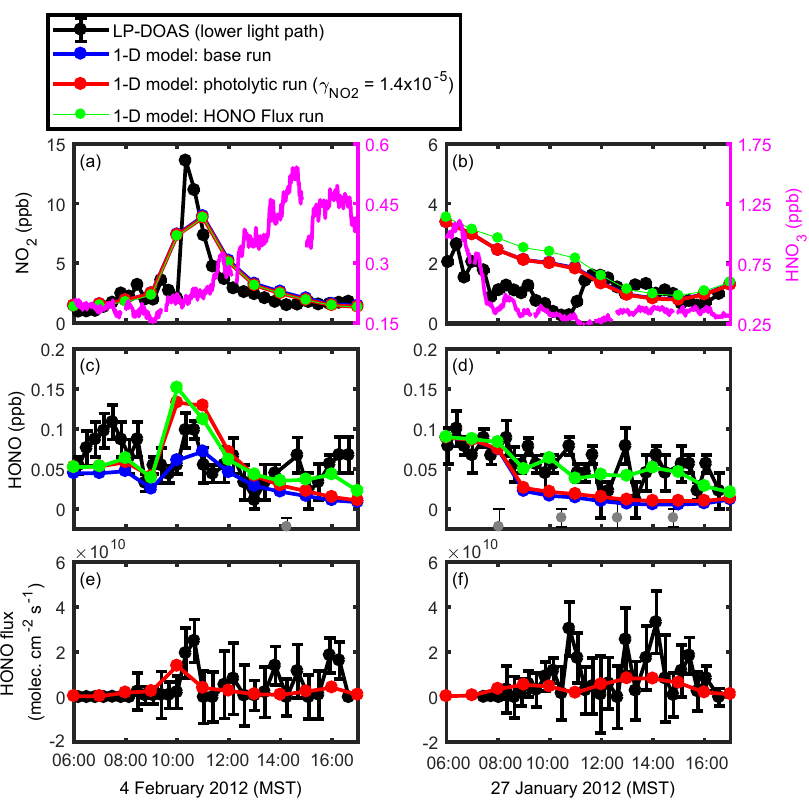
Figure 9. Comparison of modeled and measured NO 2 (a, b) , HONO (c, d) , and HONO flux at 19ma.g.l. (e, f) for 4 February 2012 ( a , c , e ) and 27 January 2012 ( b , d , f ). LP-DOAS lower light path NO 2 and HONO mixing ratios and errors are shown in black. We excluded a number of outliers (marked in grey) from the HONO analysis. These outliers are a consequence of problems with the DOAS analysis procedure for these specific measurement. Modeled NO 2 and HONO mixing ratios in the lower light-path interval using the RCAT8.2 base run are shown in blue, HONO flux run results are shown in green, and photolytic run results are shown in red (with NO 2 uptake coefficient of 1 × 10 − 6 for 4 February and 1 . 4 × 10 − 5 for 27 January). HNO 3 mixing ratios measured by NOAA are shown in magenta lines in the upper panels plots (a, b) . Error bars show the 1 σ uncertainty of the respective data